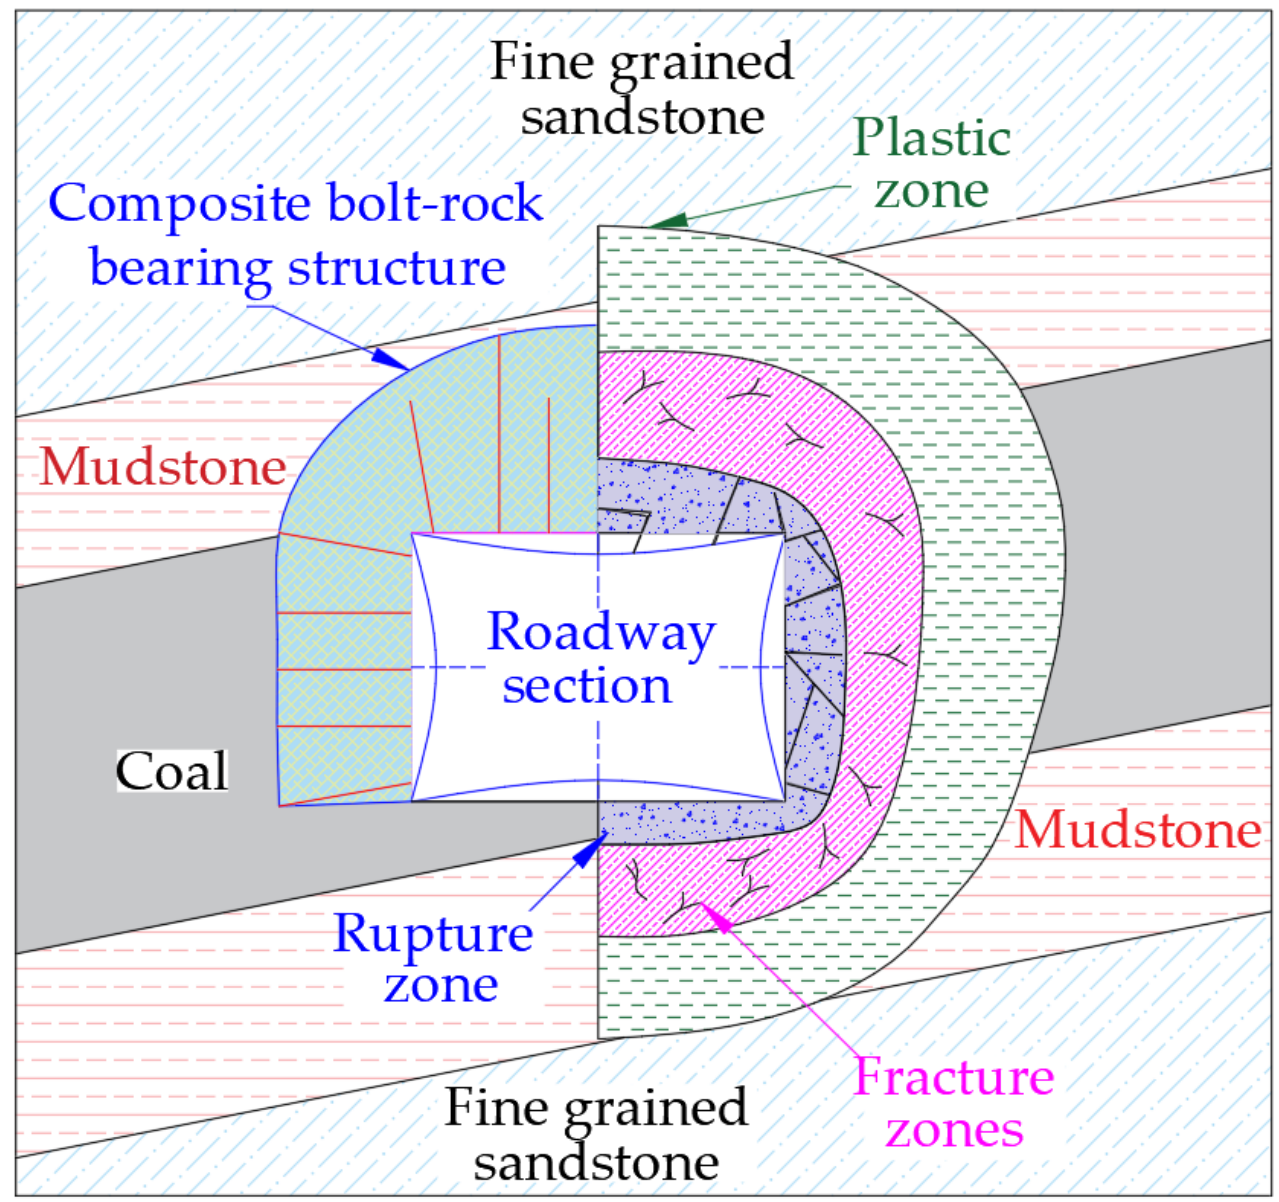
Figure 7. Model of loose and anchored composite supporting body of surrounding rocks.